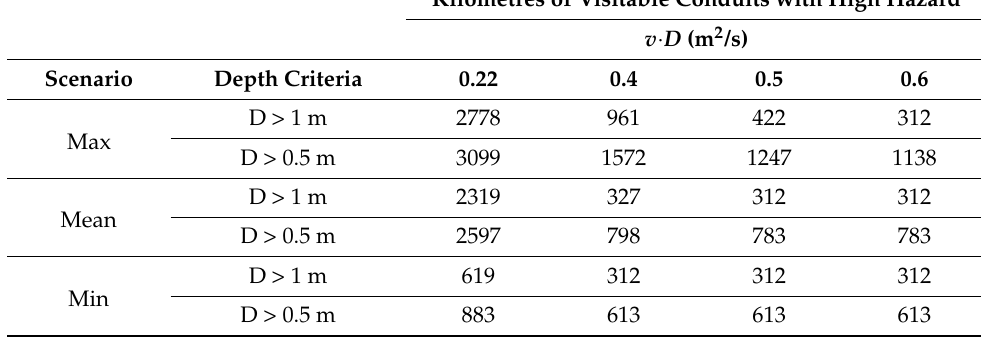
Table 2. Results of hazard assessment regarding human stability in Badalona sewer systems during dry weather conditions. Kilometres of visitable conduits with high hazard.